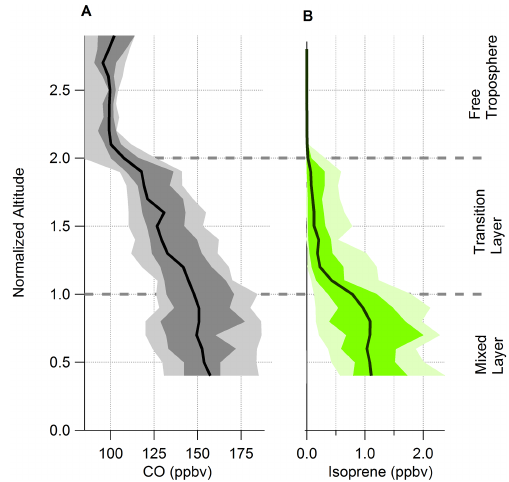
Figure 7. Altitude-normalized aggregate profiles of (a) CO; (b) iso- prene mixing ratios. The shaded regions show the interdecile range (light) and the interquartile range (medium), and the solid lines are the median